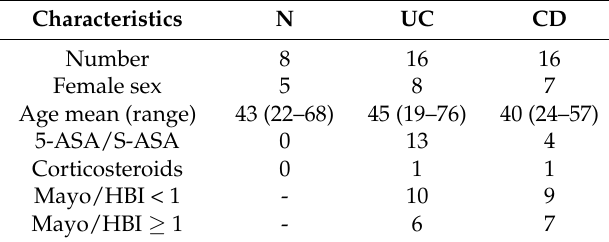
Table 1. Characteristics of subjects included in peripheral blood mononuclear cells (PBMC) analysis.